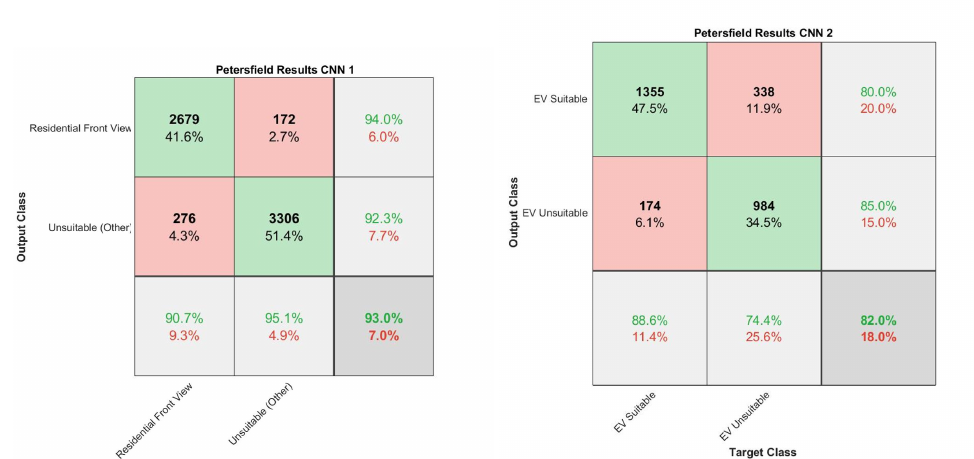
Figure 7. The resultant confusion matrices for CNN 1 and CNN 2 on the Petersfield testing data.